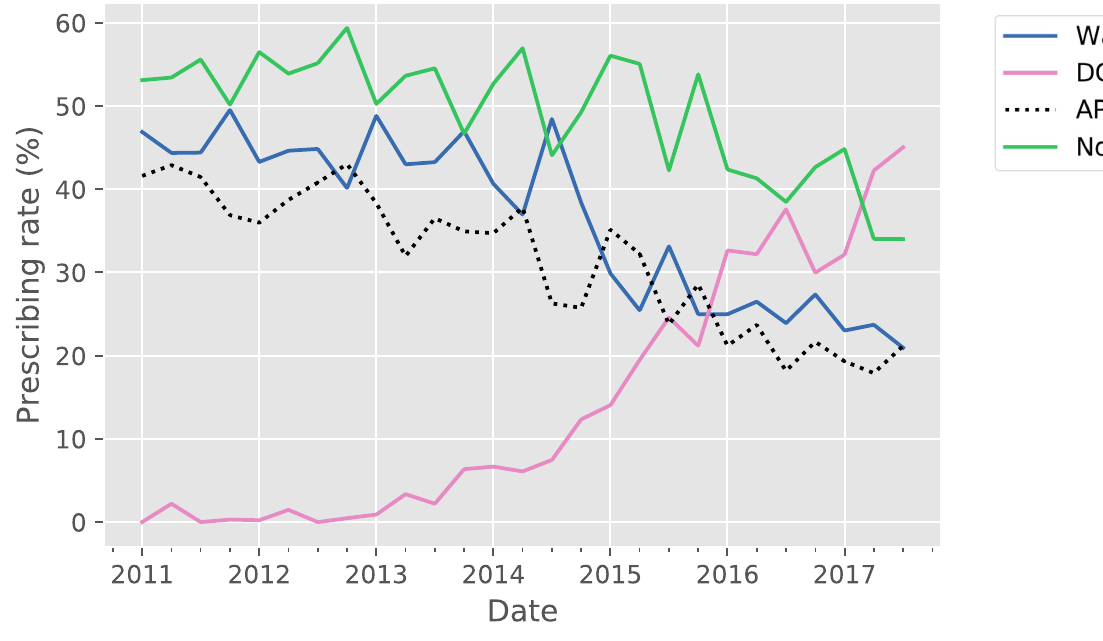
Fig 3. Prescribing trends for new AF cases over the study period. The solid blue line represents warfarin, the solid pink line represents DOAC, the dashed black line represents AP prescription without any OAC, the solid green line represents the no drug group. Total N = 4986. AP = antiplatelet, DOAC = direct oral anticoagulant, OAC = oral anticoagulant.